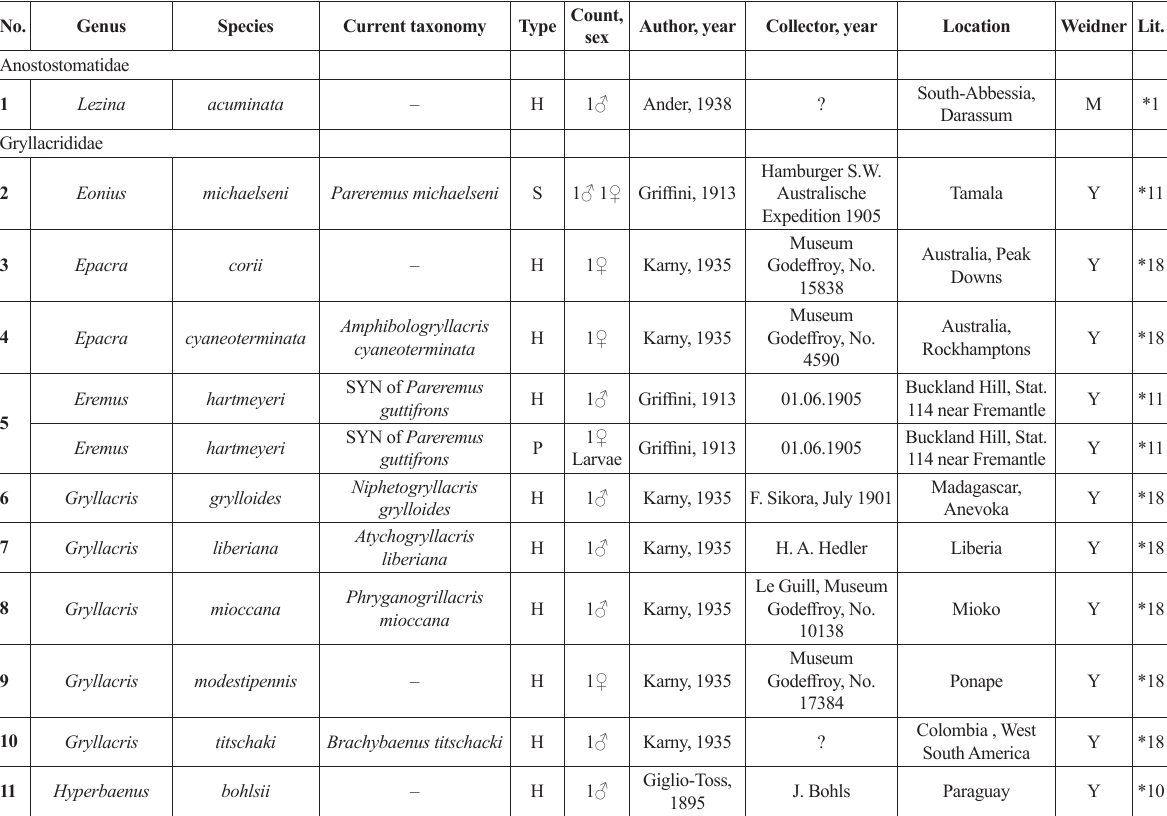
Table 1. The table shows all type specimens housed in the collection of the ZMH including the original genus and species name, the type status indicated by the abbreviations H for holotype, P for paratype, S for syntype, A for allotype, L for lectotype, PL for paralectotype, N for neotype, and NA for neoallotype. The number and sex of type specimens are shown. Moreover, the table shows information about author and year of description of the material. The collector, date of collection and collection location are provided. We also present the current nomenclature as in Cigliano et al. (2018). Additionally, the old type catalogues of Weidner (1966, 1977) were compared with the present list (Y = yes, the species was present in Weidner (1966, 1977), M = missing and N = no, the material was not recorded in the old type catalogue. The Lit . column shows the reference number of the original description (* Ref.); in case of a lecto-, or paralectotype the author and year of type designation are presented (# Ref.). The references of the numbers are included below. Question marks indicate missing information of a specimen. All location data is directly transcribed from labels and not